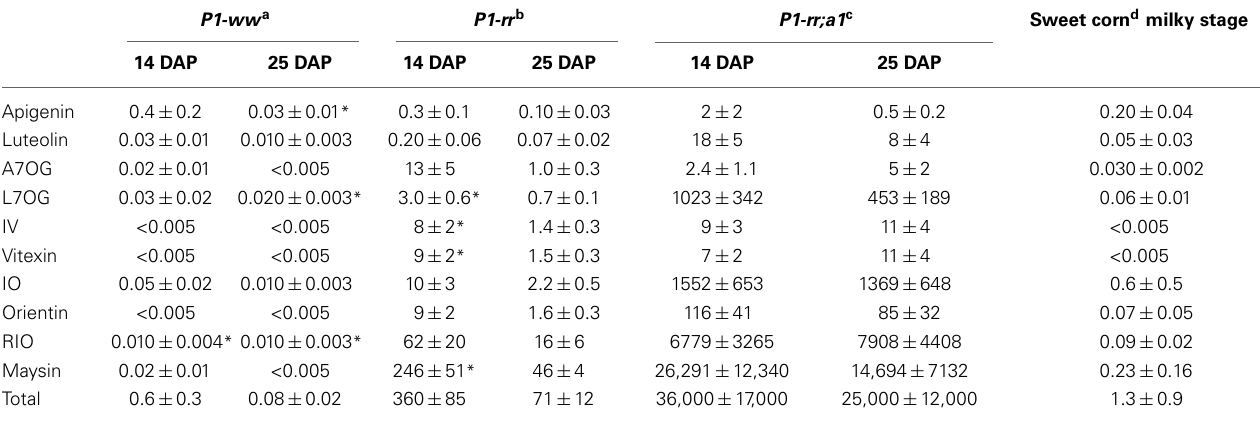
Table 1 | Flavone content in non-hydrolyzed whole maize